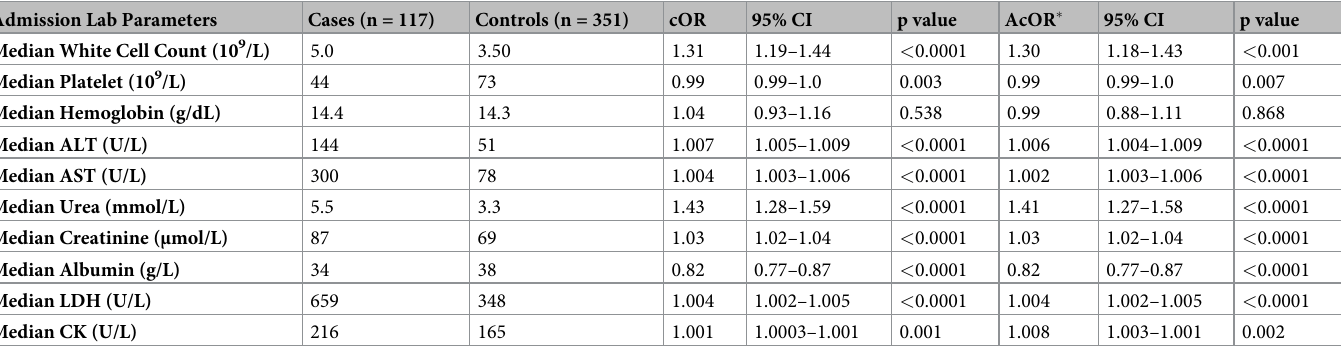
Table 4. Admission laboratory parameters of cases (severe dengue) compared to controls (non-severe dengue). Admission Lab Parameters